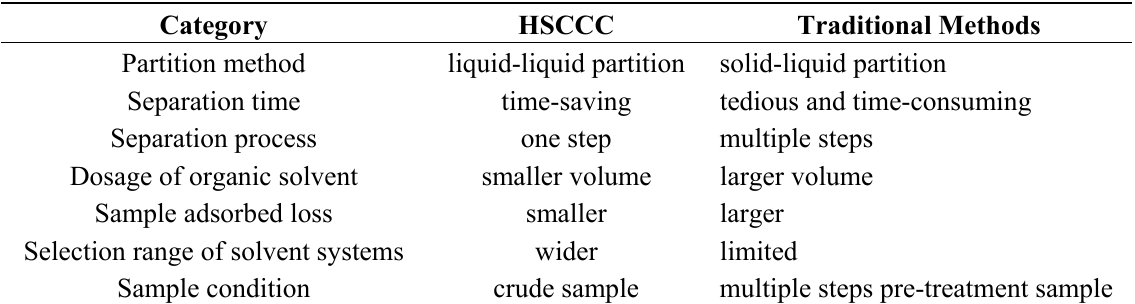
Table 1. The compare of high-speed counter-current chromatography (HSCCC) and the traditional